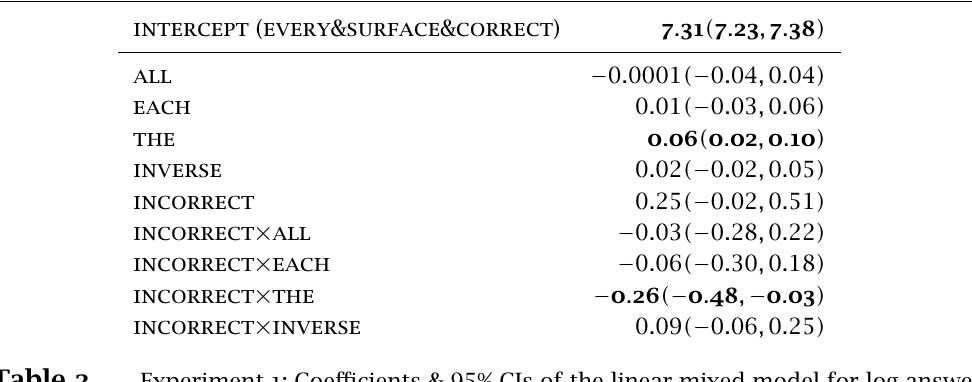
Experiment 1 : Coefficients & 95 % CIs of the linear mixed model for log answer